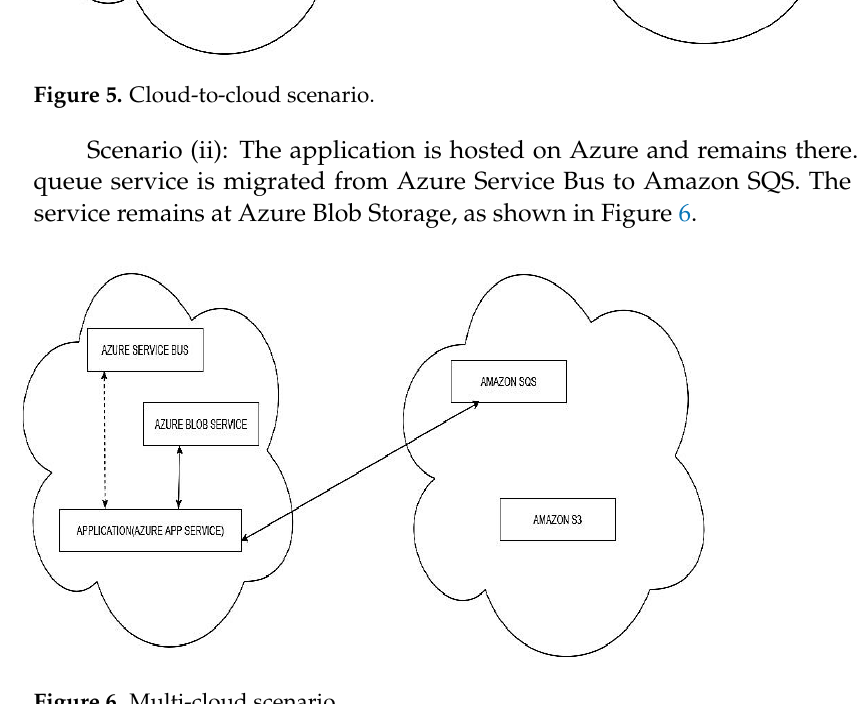
Figure 7. Hybrid cloud scenario. 5. Conclusions and Future Work The benefits of using clouds, such as cost savings, improved agility while managing the computing infrastructure, and the enhanced speed of system realization, lure consum- ers into migrating their services, data, and applications to a cloud. PaaS is the cloud com- puting paradigm layer where software developers primarily work on their applications as operations teams are responsible for infrastructure and hosting (IaaS layer). However, porting an application developed on one platform to another is not a trivial task. Middle- ware has been proposed in this paper to provide the developer with the facility to create a platform-independent cloud application. Microsoft Azure, Amazon Web Services, and Google Cloud Platform have currently supported cloud platforms. Developers can focus on their business logic rather than implementing the services for different clouds. Alt- hough the middleware does add mild latency to the services, it saves developers time by handling the implementations under the hood of abstraction of the services in the middle- ware. Our primary performance focus includes BLOB service and message queue service,